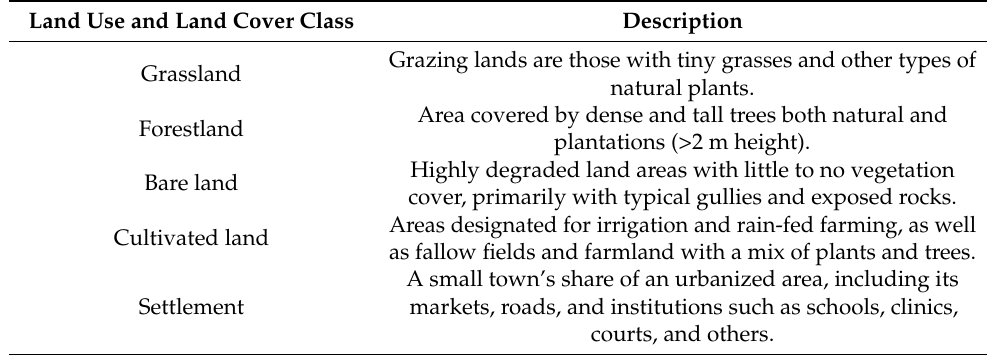
Table 2. Description of classified LULC in the Matenchose watershed. Land Use and Land Cover Class Description Grassland Forestland